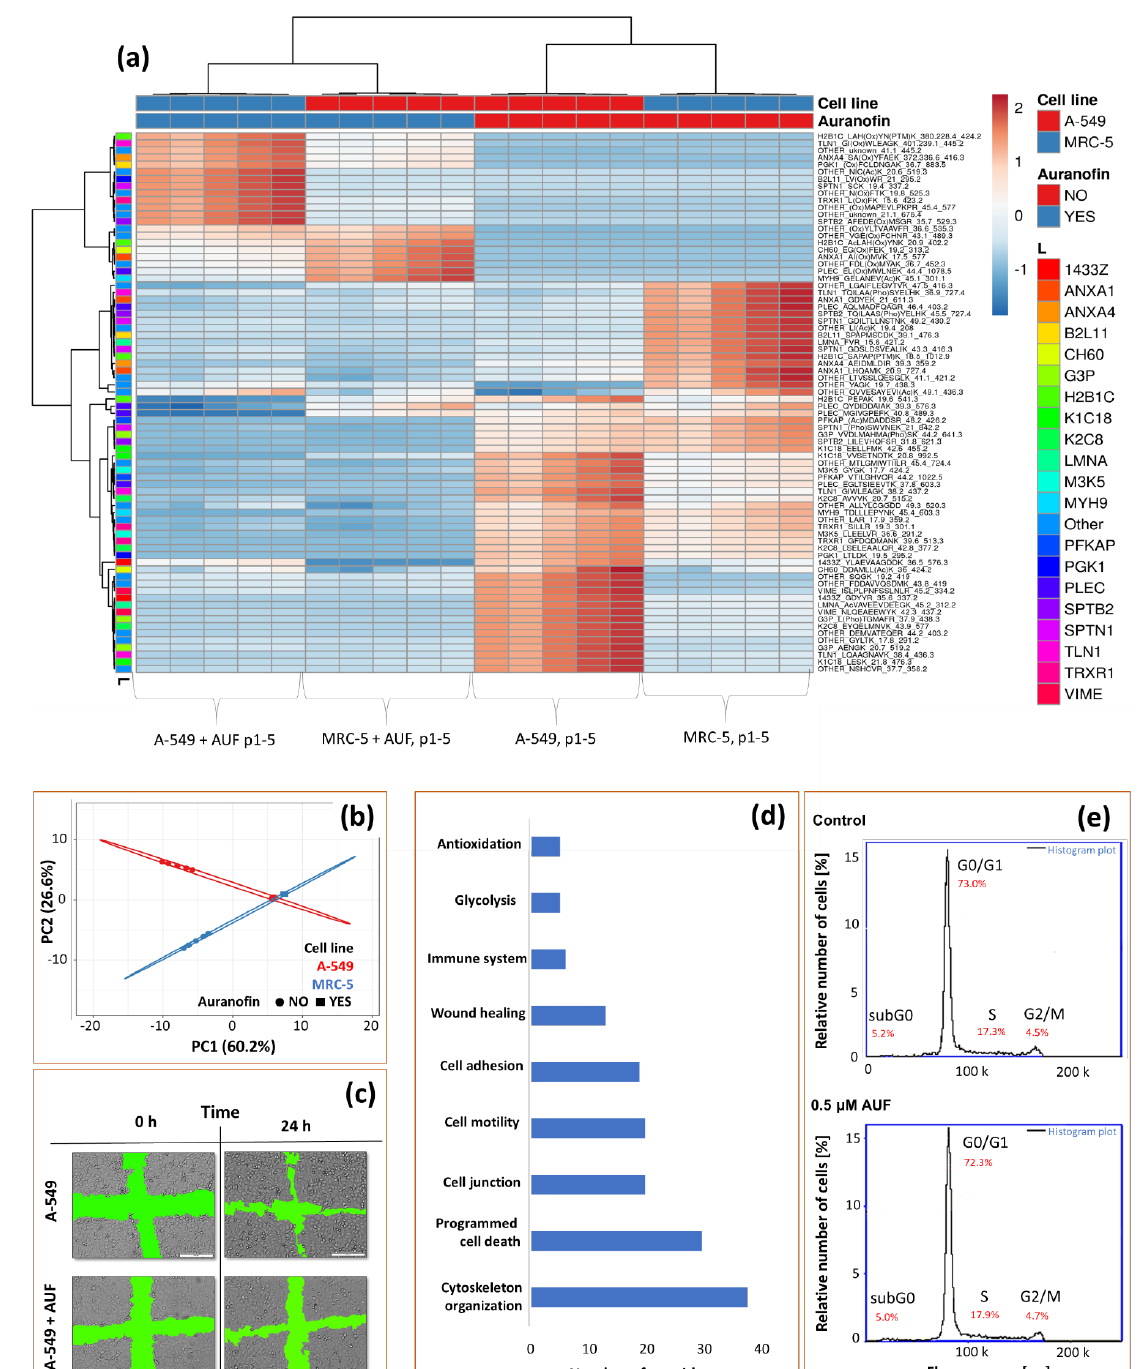
Figure 6. Heatmap ( a ) showing changes in the peptide’s composition registered by µRPLC-ESI-MS related to 20 proteins due to the activity of auranofin. Principal component analysis, PCA chart ( b ) shows the main differences between A-549 and MRC-5 cells before and after auranofin exposure. Images ( c ) present the influence of auranofin on cell motility of A-549 cells (wound healing test). Chart ( d ) presents the number of peptides related to proteins with specified functions. Graphs ( e ) present no influence of auranofin on cell cycle.